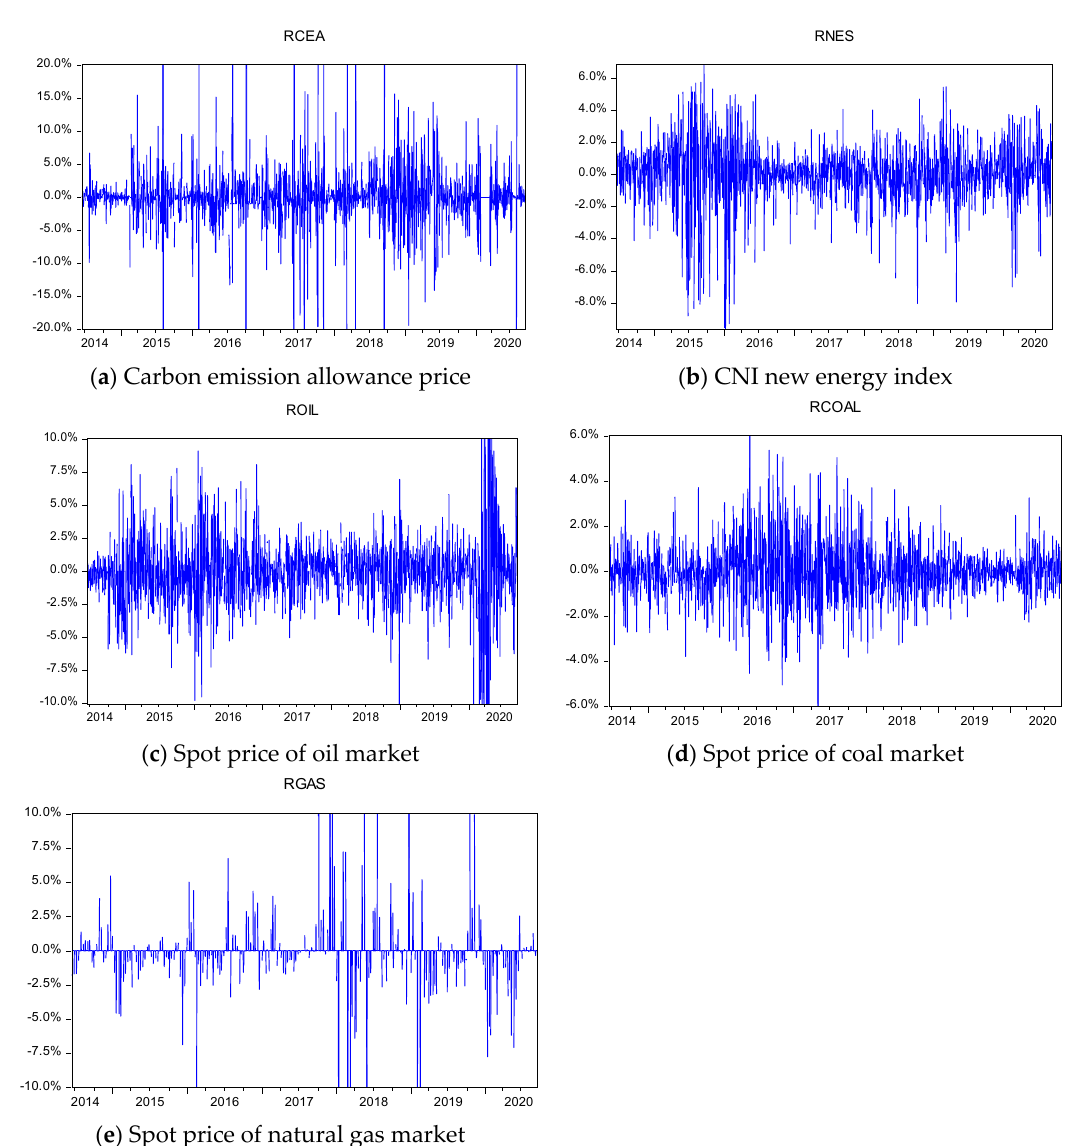
Figure 1. The price returns of carbon allowance and the stock of new energy companies and fossil energies.